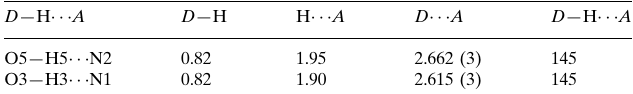
Hydrogen-bond geometry (A˚ , (cid:2)